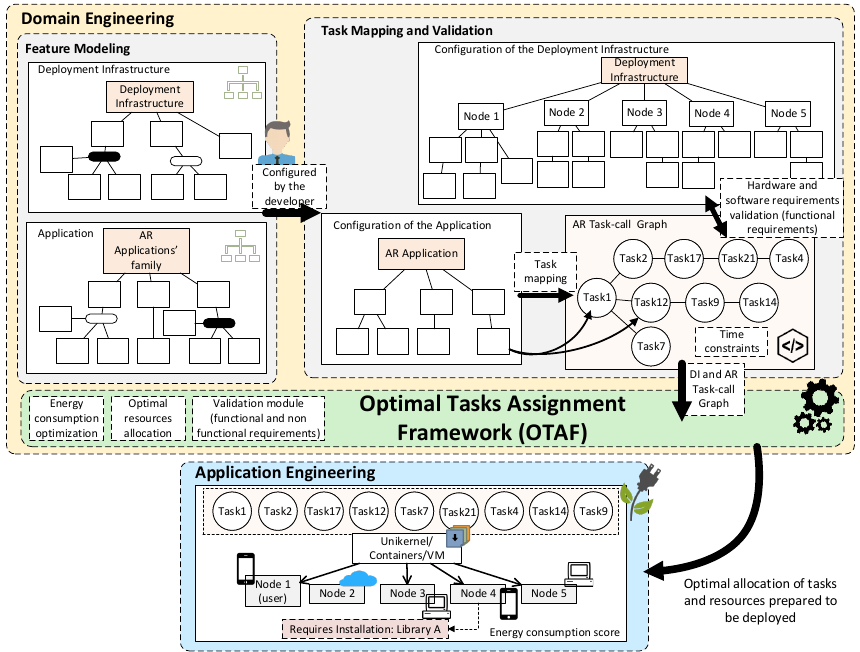
Figure 1. Overall view of the processes and models involved in our